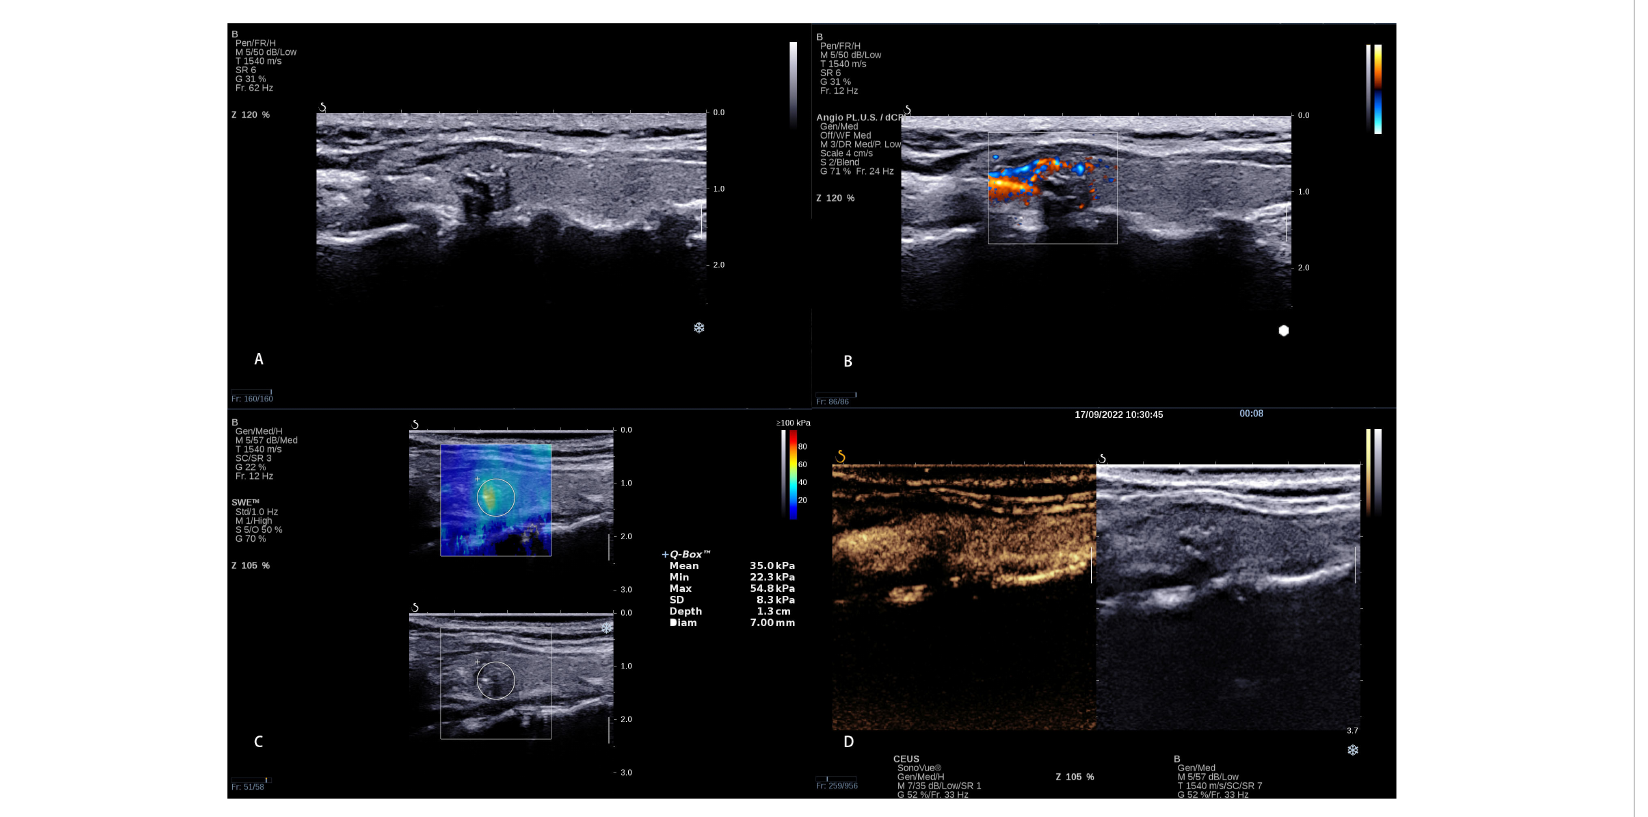
FIGURE 3 A 8 × 6 mm thyroid nodule in the left lobe of a 38-year-old woman. (A) Conventional ultrasound showed a solid hypo-echoic, irregular nodule with calci fi cations; the shape was wider than taller and the contact extent with adjacent thyroid capsule >25%. (B) AP shows that the vascularization of nodule could be classi fi ed as Grade I (C) SWE measurement shows that Emin, Emean, and Emax were 22.3 kPa, 35.0 kPa, and 54.8 kPa, respectively. (D) CEUS shows interrupted capsule at CEUS. The calculated predictive value with the logistic regression formula was 2.35 (>2.0805), which was regarded as presence of